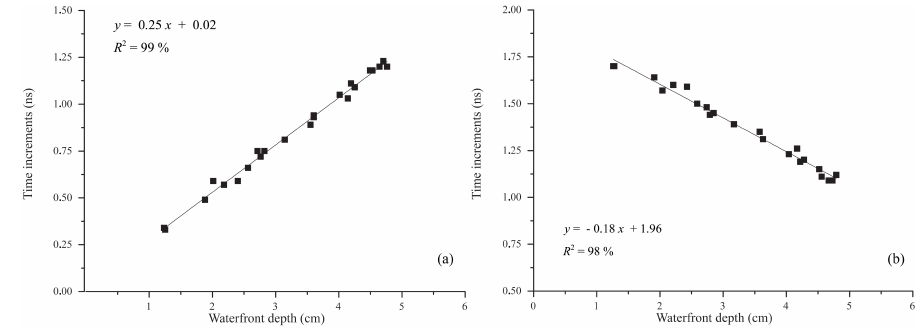
Figure 7. (a) Adjustments of the arrival time increment between D2 and waterfront reflection (F3) and waterfront depths; (b) arrival time increment between R3 and waterfront reflection (F3) and waterfront